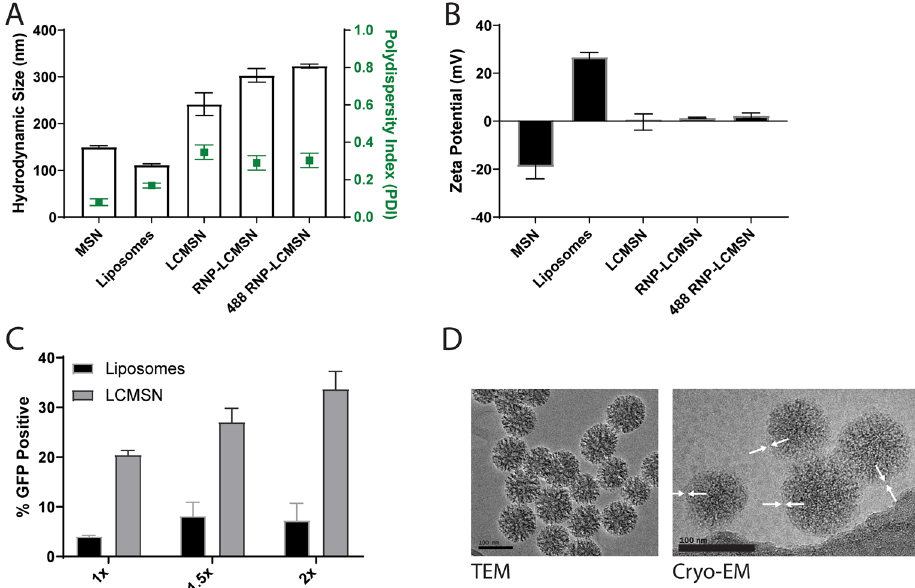
Figure 2. Formation analysis, dose-dependent editing, and ultrastructure characterization of the down- selected RNP-LCMSN. ( A ) Hydrodynamic size and polydispersity index values for nanoparticle and liposome formulations. ( B ) Zeta-potential of nanoparticle and liposome formulations. ( C ) Editing efficacy of LCMSN and liposomes in a GFP-reporter assay (Figure S1). 1x = 5.5 µg RNP = 40 µγ MSN, 1.5 = 8.4 µg RNP = 60 µγ MSN, and 2x = 11.2 µg RNP = 80 µγ MSN. ( D ) TEM and Cryo-EM images of DCD3330